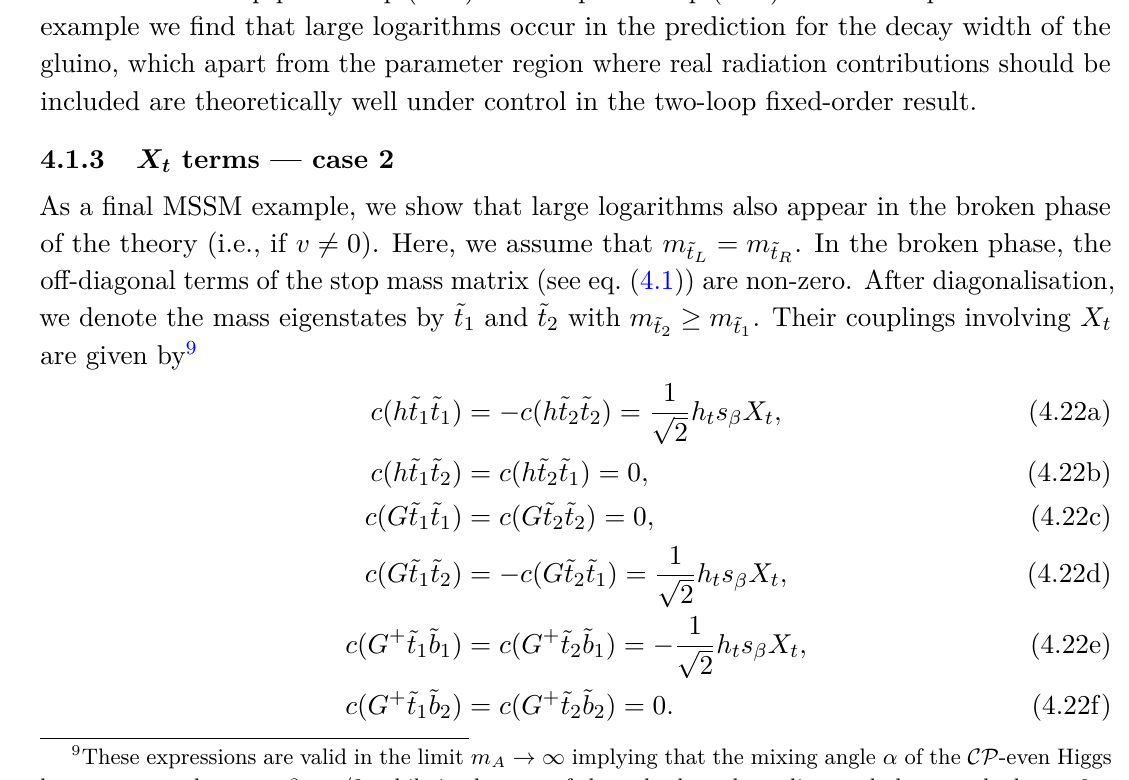
Figure 12. The gluino decay widths ˜ g → t + ˜ t L,R as a function of m ˜ t + ˜ t L is displayed by the solid curves and t + ˜ t R by the dashed curves. The one-loop results including all corrections in leading powers of X t are shown relative to the tree-level decay width by the blue curves, while the corresponding two-loop results are displayed by the red